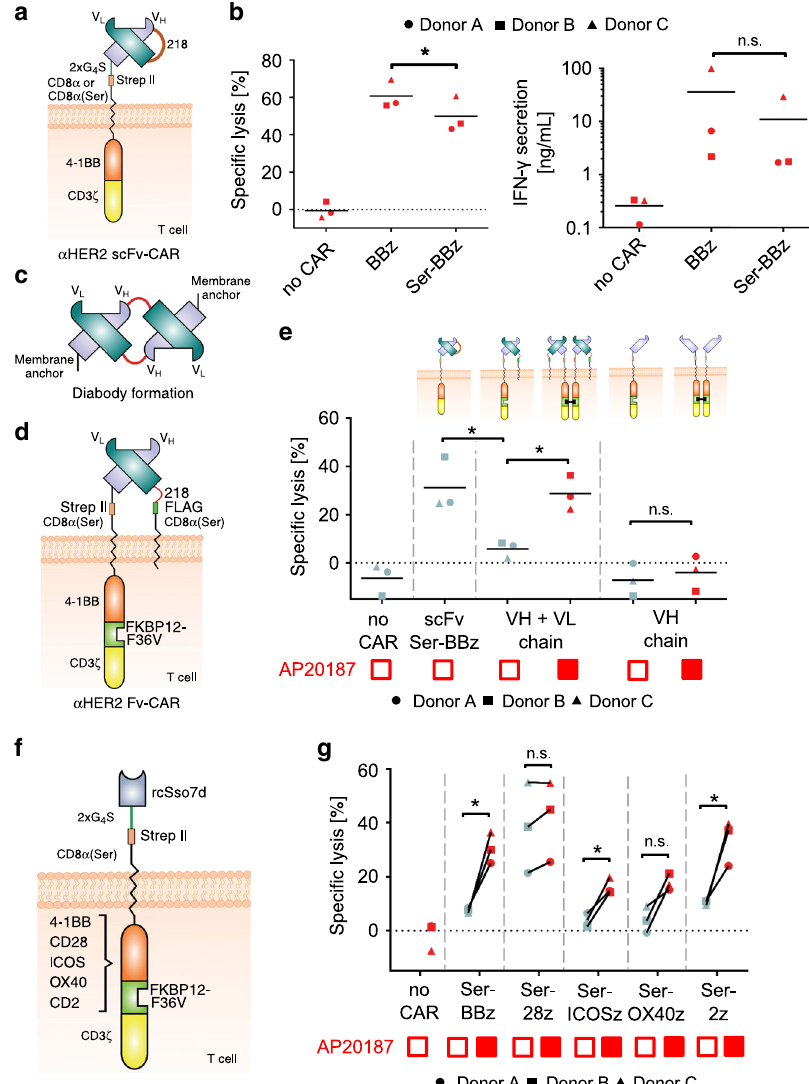
Fig. 3 In fl uence of extra- and intracellular CAR domains. a , b Clustering of a hHER2-speci fi c scFv. scFv-containing CARs were either based on a BBz and Ser-BBz-backbone, as shown in ( a ) (SEQ-IDs 5 and 6, respectively). b The fi gure shows the cytolytic and secretory activity of mock-T cells (no CAR) and T cells expressing the BBz- or Ser-BBz-CAR in co-cultures with hHER2t pos Jurkat cells [ fl ow cytometry-based assay; three independent experiments with different donors; * p < 0.05, calculated by two-tailed paired t -test (left panel) or by two-tailed ratio-paired t -test (right panel)]. c Schematic of diabody formation of two scFvs by intermolecular heterodimerization of VHs and VLs. d , e Prevention of diabody formation enables de fi ned CAR dimerization. d Schematic of a CAR with VH and VL on separate polypeptide chains for preventing diabody formation (SEQ-IDs 7 and 8). Both constructs are shown in the heterodimerized state together forming a hHER2-speci fi c Fv-based CAR. e Cytolytic activity of mock-T cells (no CAR) or T cells expressing either the hHER2-speci fi c scFv-CAR [shown in ( a )] or the VH and VL constructs [shown in ( d )] in co-cultures with hHER2t pos Jurkat cells. AP20187 was added for homodimerization of the VH-construct as indicated ( fi lled red boxes). [ fl ow cytometry-based assay; two independent experiments with three different donors; * p < 0.05, calculated by two-tailed paired t- test and by two-tailed unpaired t -test (scFv Ser-BBz vs. VH + VL chain)]. f , g In fl uence of co- stimulatory domains. f Schematic of hEGFR-speci fi c rcSso7d-based low-af fi nity CARs which contain different co-stimulatory domains. The 4-1BB domain of the AvidCAR was substituted by the endodomain of CD28, ICOS, OX40, or CD2 (SEQ-IDs 9, 10, 11, 12, and 13, respectively). The FKBP12-F36V domain was integrated for conditional homodimerization. g rcSso7d-based low-af fi nity CARs with different co-stimulatory domains were expressed in T cells and co- cultured with hEGFRt pos Jurkat cells. The fi gure shows the cytolytic activity of the T cells and its dependence on AP20187-mediated CAR dimerization ( fl ow cytometry-based assay; two independent experiments with three different donors; * p < 0.05, calculated by two-tailed paired t- test). Exact p values are given in Supplementary Data 2. Source data are provided as a Source data fi